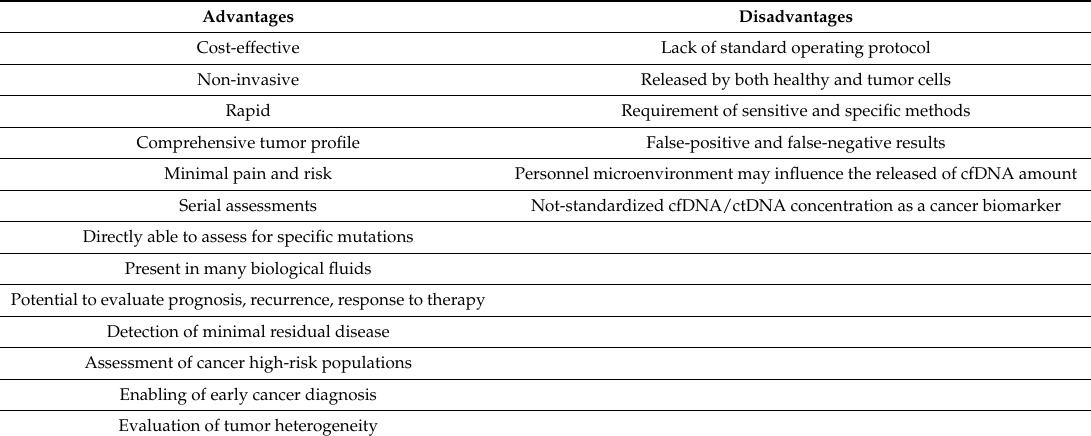
Table 1. The advantages and disadvantages of a liquid